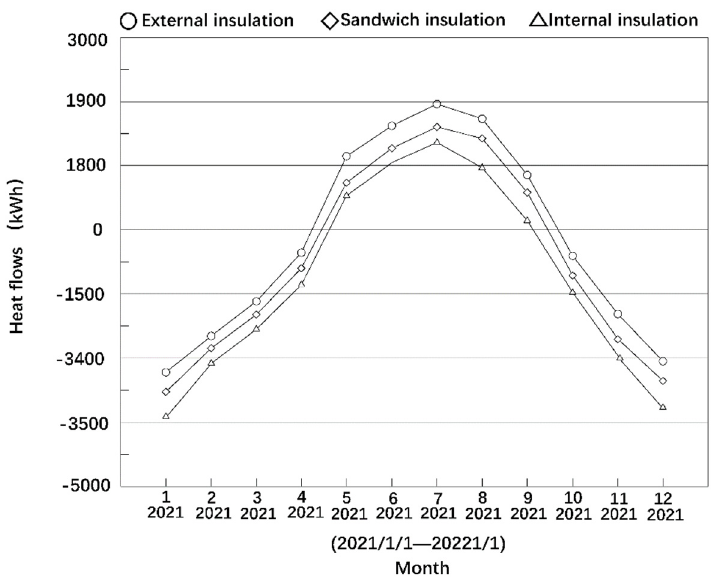
Figure 14. Average monthly heat flow for walls of different construction forms.